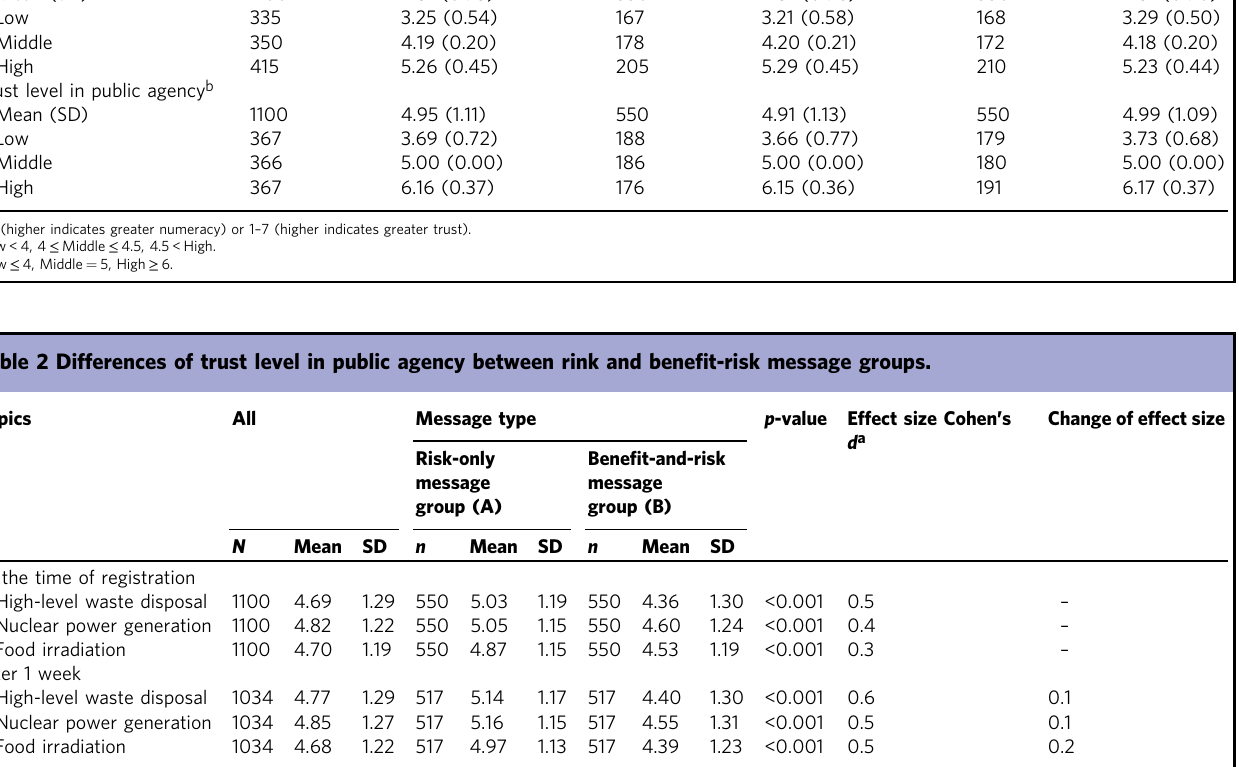
At the time of registration High-level waste disposal 1100